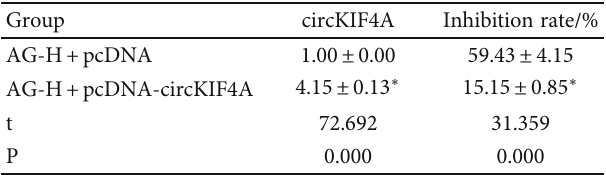
Table 4: Detection of impacts of circKIF4A on Amarogentin (AG)-intervened HGC-27 multiplication, migration and apoptosis ( (cid:1) x ± s , n = 9